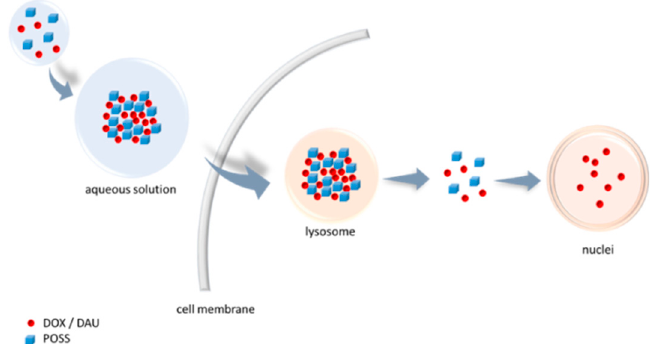
Figure 1. Scheme of co-delivery of a hydroxyl functionalised polyhedral oligomeric silsesquioxane (POSS(OH) 32 ) and an anthracycline (e.g. doxorubicin [DOX] or daunorubicin [DAU]) into the cell.